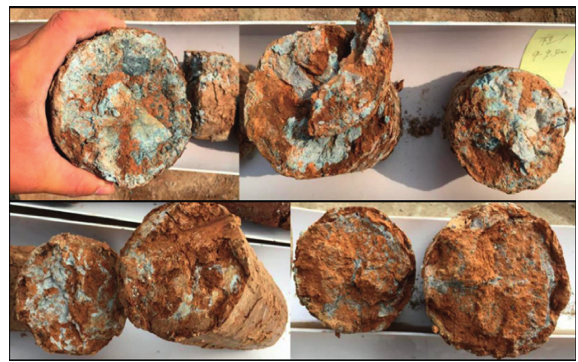
Figure 13: Drilling and coring of reinforced